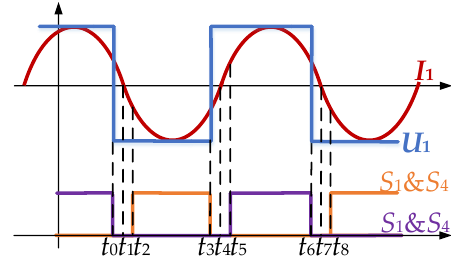
Figure 5. Waveforms of U 1 & I 1 and gate signals of the inverter in a full switching cycle with f d > f r . When the input impedance of the inverter is capacitive, the zero-current point of I 1 is shifted out of the dead-time and the output voltage and current waveforms of the converter in a full cycle are